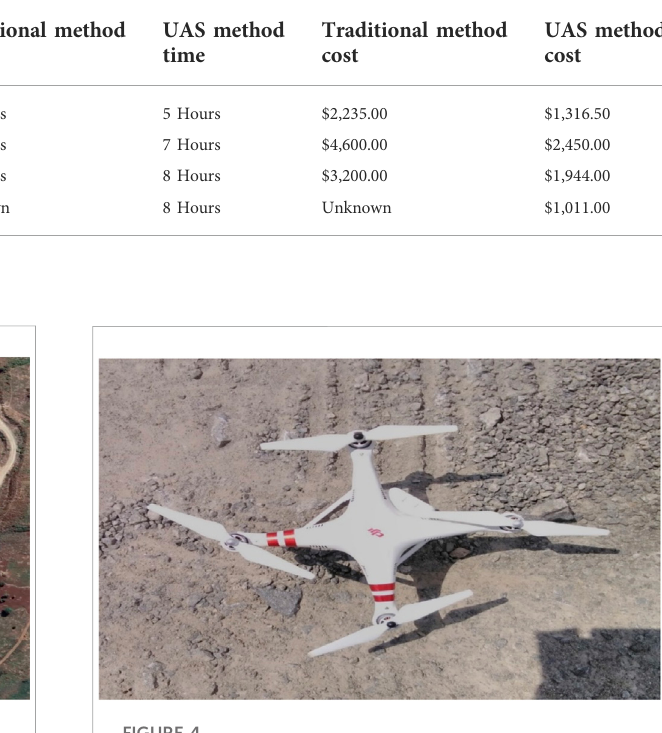
FIGURE 3 Google Earth image of the study area (Google Earth 2021).